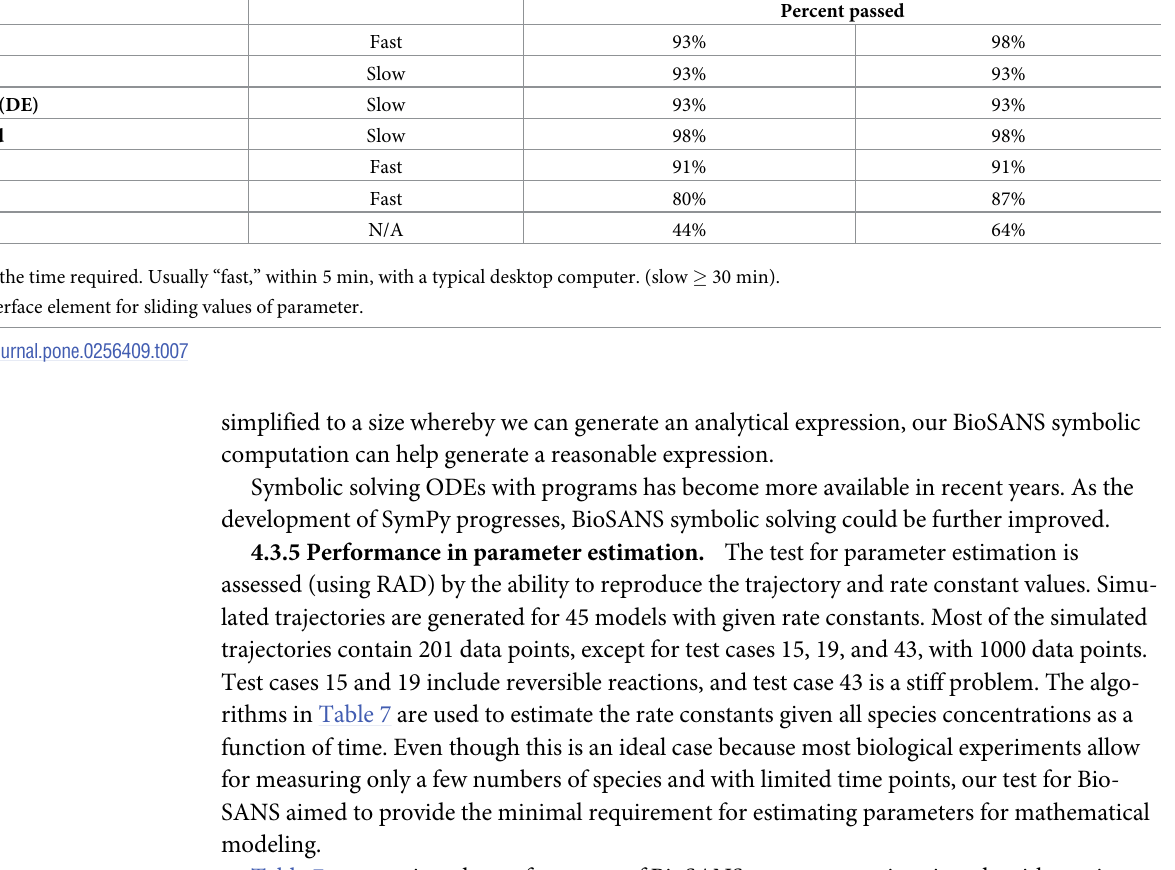
Table 7. Performance of different algorithms in BioSANS for parameter estimation.